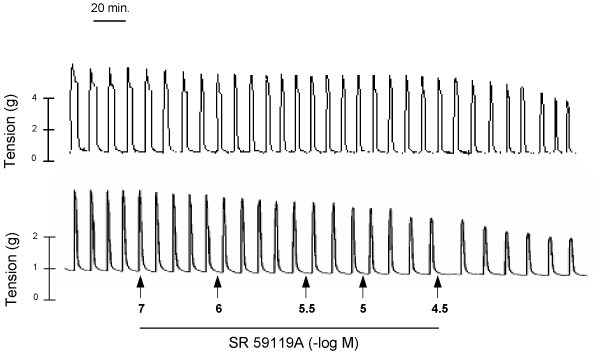
Representative recording of the effect of SR 59119A on spontaneous contractions of human non-pregnant (upper trace) and near-term (lower trace) myometrial strips.